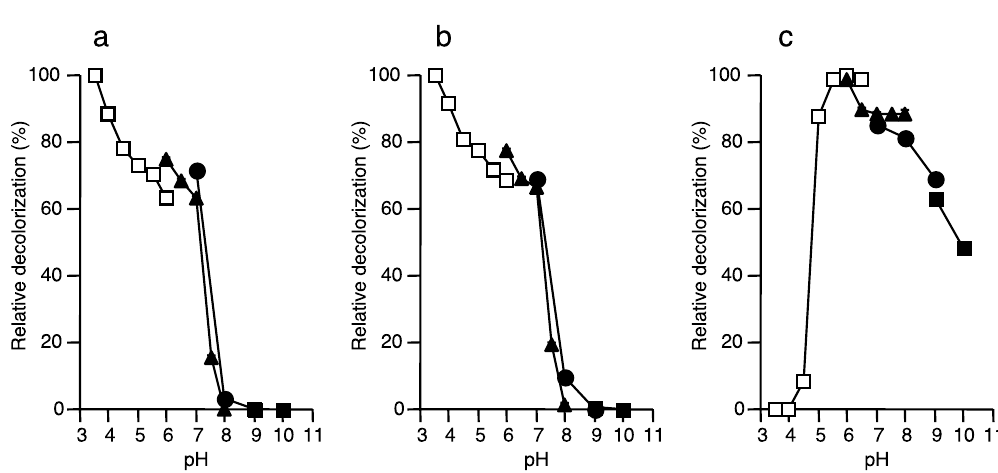
Figure 4. Effect of pH on Orange G decolorization activities by TvL ( a ), PoL ( b ), and IOX ( c ). The reaction mixture contained 10 mU mL − 1 each of enzyme, 0.3 mM of dye, and 20 mM of appropriate buffers. Potassium iodide (for IOX) or ABTS (for TvL and PoL) was also added at 0.1 mM. Buffers used were sodium acetate (open squares), potassium phosphate (triangles), Tris-HCl (circles), and glycine-NaOH (closed squares). The reaction time was 48 h. Percentages decolorization at relative decolorization of 100% by TvL, PoL, and IOX were 86%, 93%, and 80%,